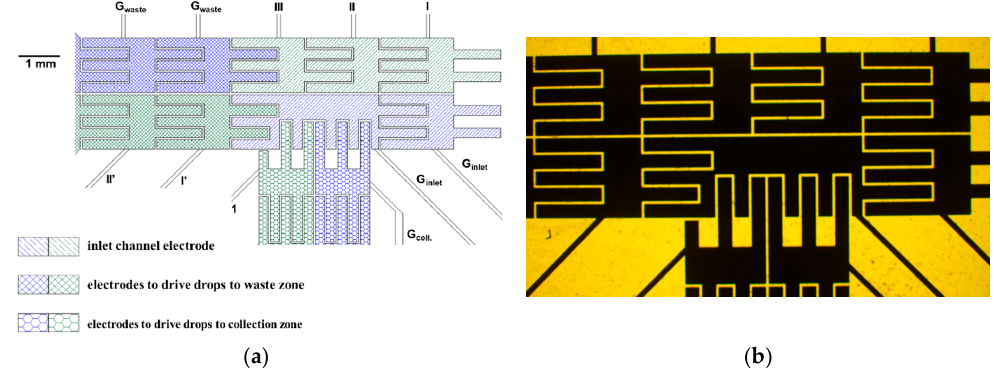
(filled with green oblique line patters): activation electrodes to drive droplet from the inlet to the detection zone. Electrodes I’ and II’ (filled with green mesh patterns): activation electrodes to drive droplet from the detection zone to the waste zone. Electrode 1 (filled with green honey cone Filled with blue patters: ground electrodes of the aforementioned three channels; and, ( b ) the image